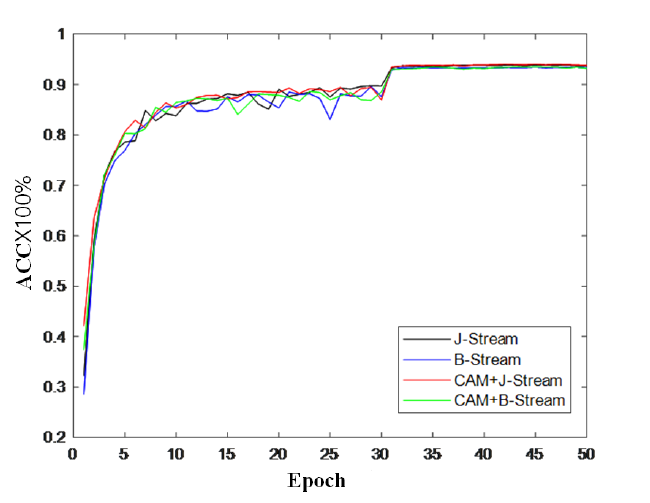
Figure 9. Accuracy change curve on CV index of NTU-RGB + D.